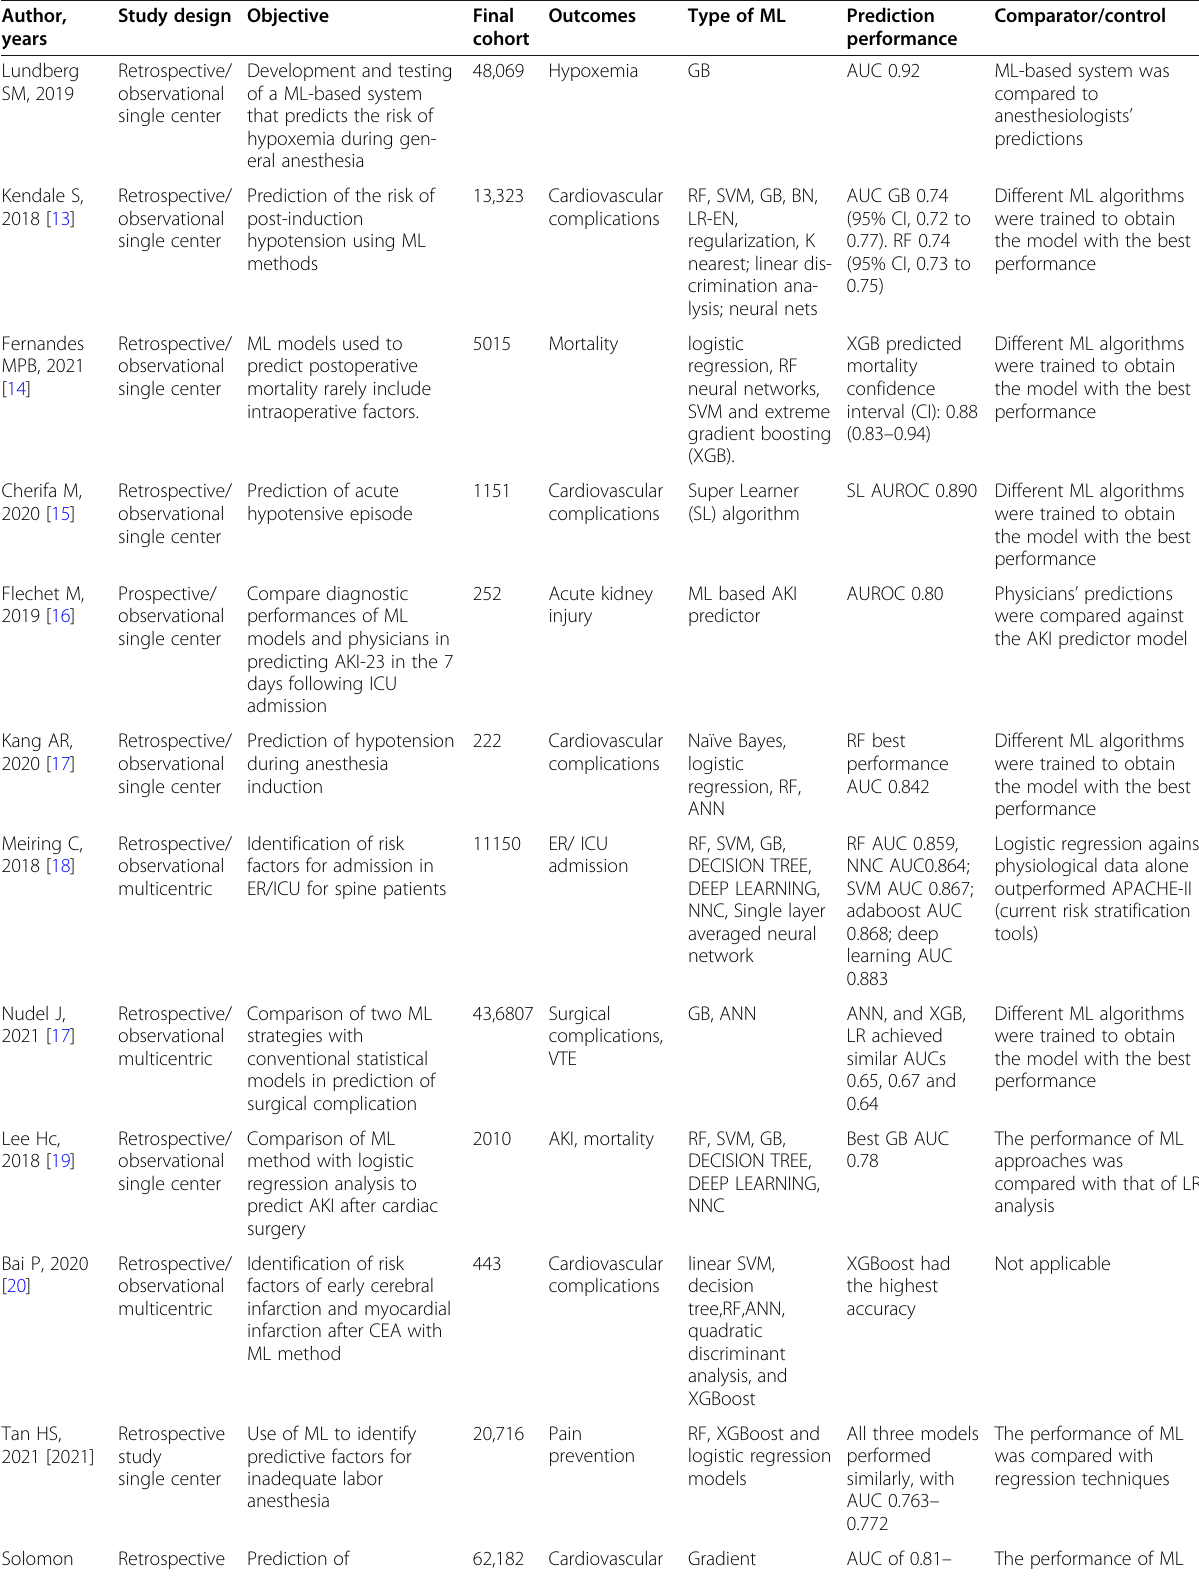
Table 1 Overview of papers included in our